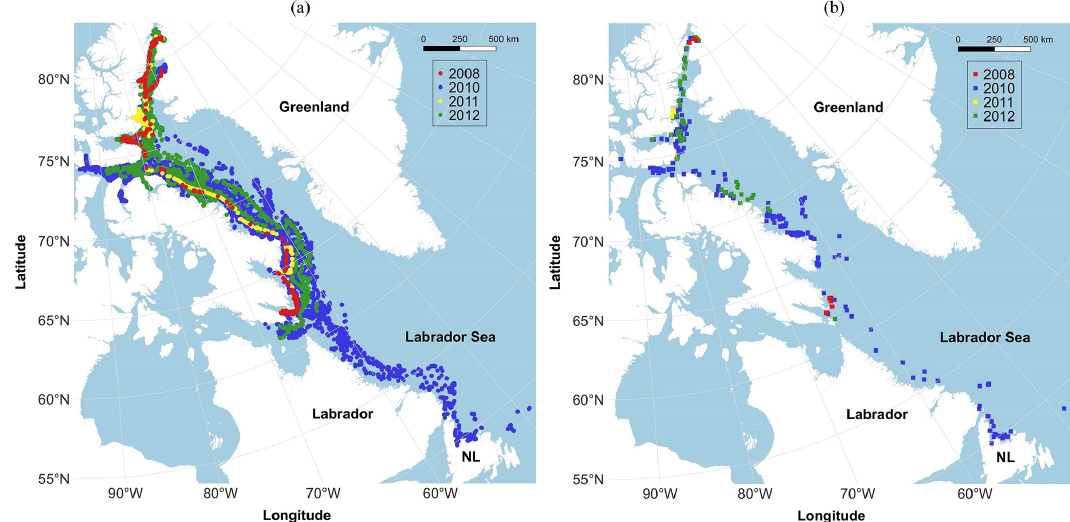
Figure 2. The drift trajectories (a) and the locations of fracture events (b) for the ice islands originating from the calving events of Petermann Glacier in 2008 (red), 2010 (blue), 2011 (yellow), and 2012